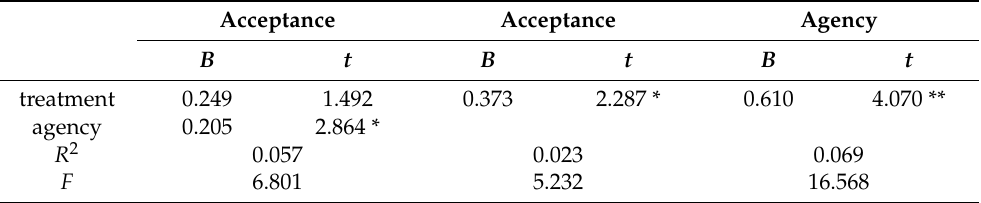
Table 3. Mediated model test for agency.